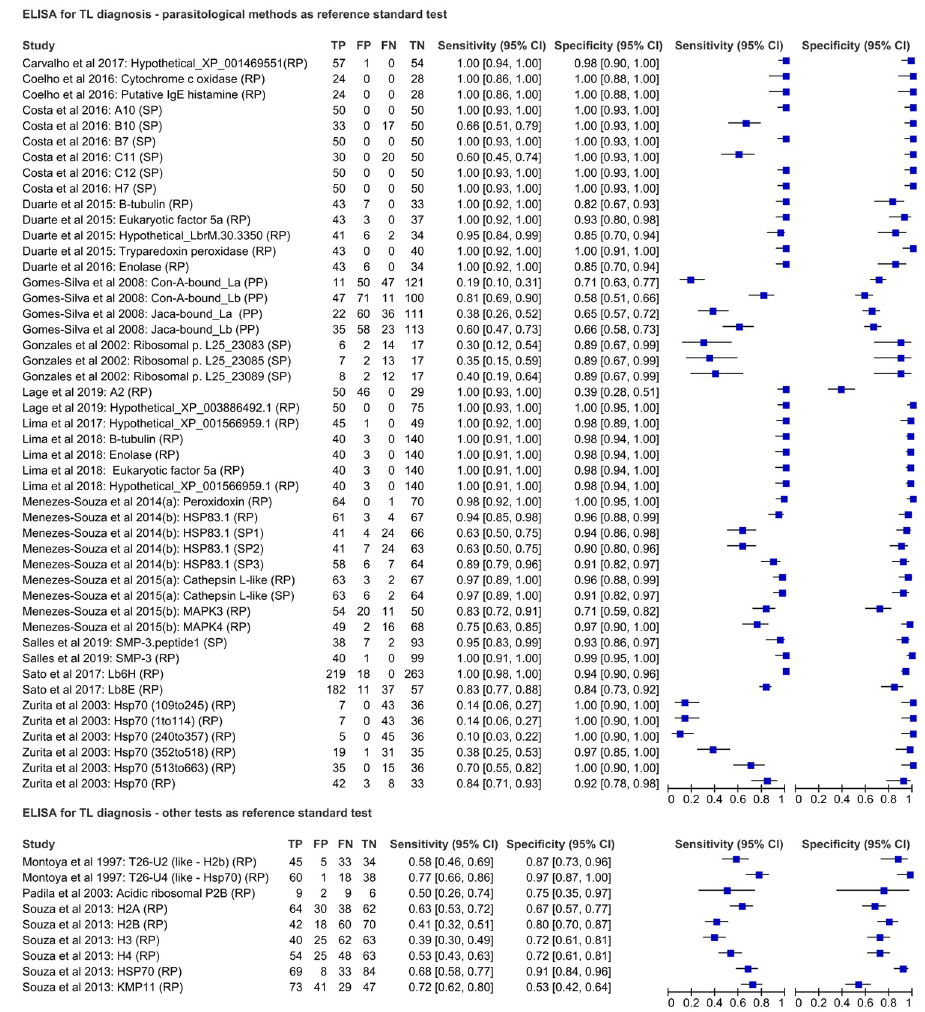
Fig 2. Forest plot representing sensitivity and specificity indices of ELISA using different antigenic targets for TL diagnosis.